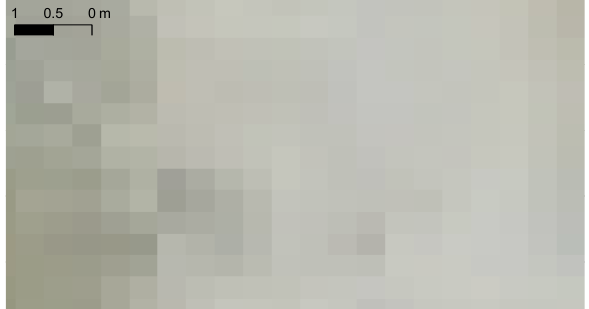
Figure 6: The same area than the figure 5 with the IGN 50cm cell size